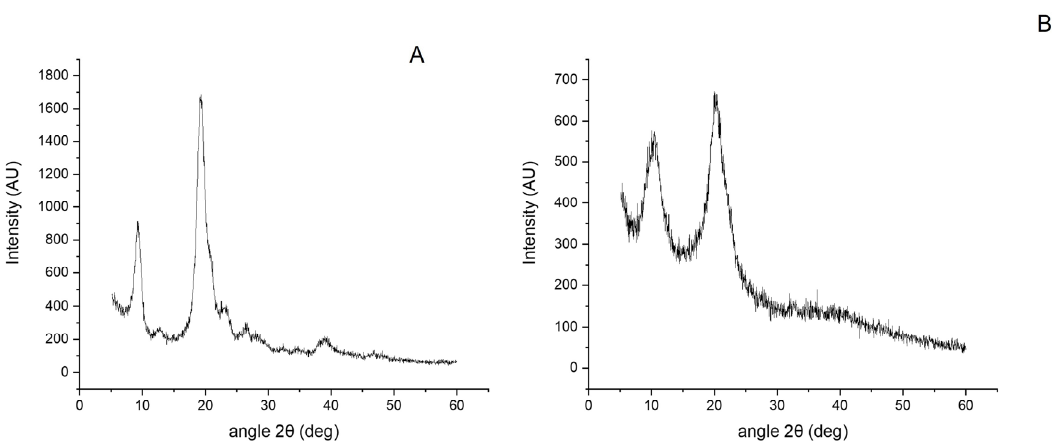
Figure 2. XRD pattern of chitin ( A ) and chitosan ( B ) isolated from Saduria entomon .